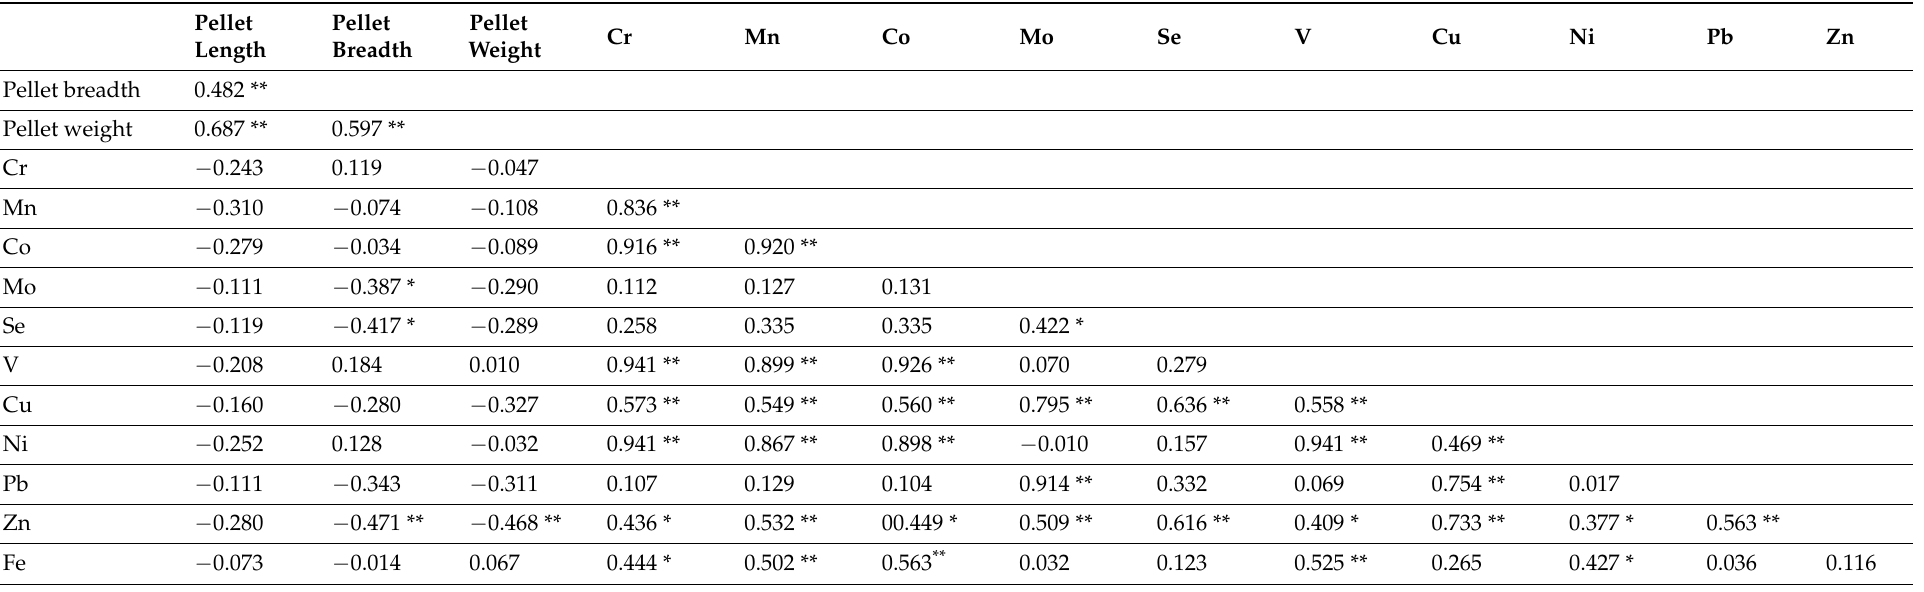
Table 3. Pearson correlation showing the relationships among the metal collected from the five different species of owls from the farmlands of the Cauvery Deltaic